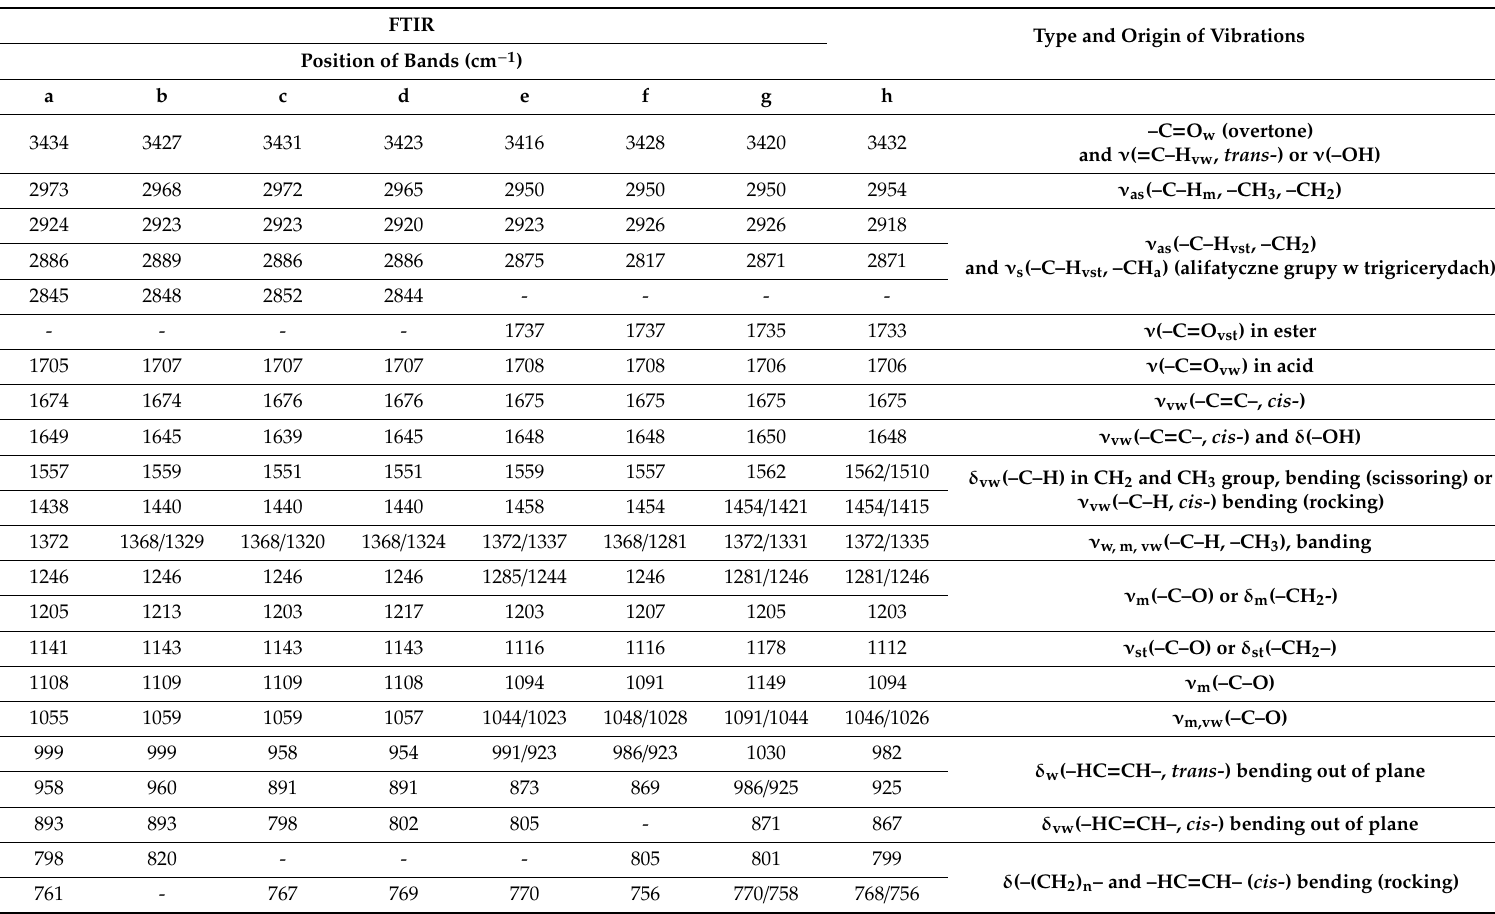
Table 4. The location of the maxima of absorption bands FTIR [31,32] with arrangement of appropriate vibrations for selected for sampling: a—Caraway, b—Caraway 150 IMP, c—Caraway 250 IMP, d—Caraway 350 IMP, e—Peppermint, f—Peppermint 150 IMP, g—Peppermint 250 IMP, h—Peppermint 350 IMP made in terms of spectra 3700–730 cm − 1